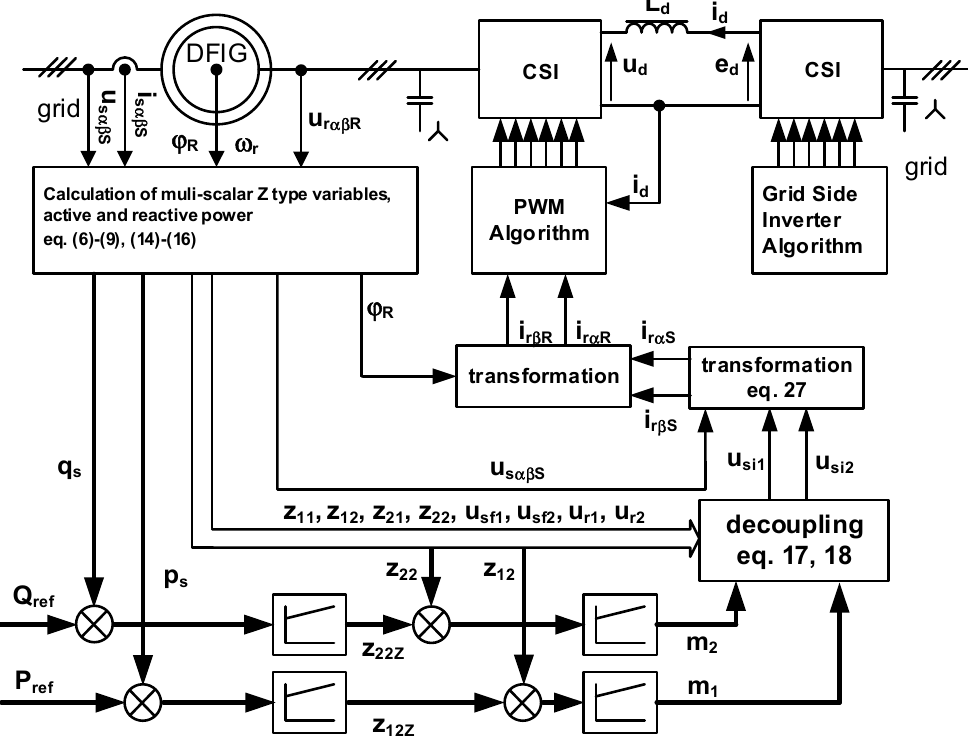
Figure 2. Schematic diagram of the nonlinear control strategy. PWM: pulse width modulation.